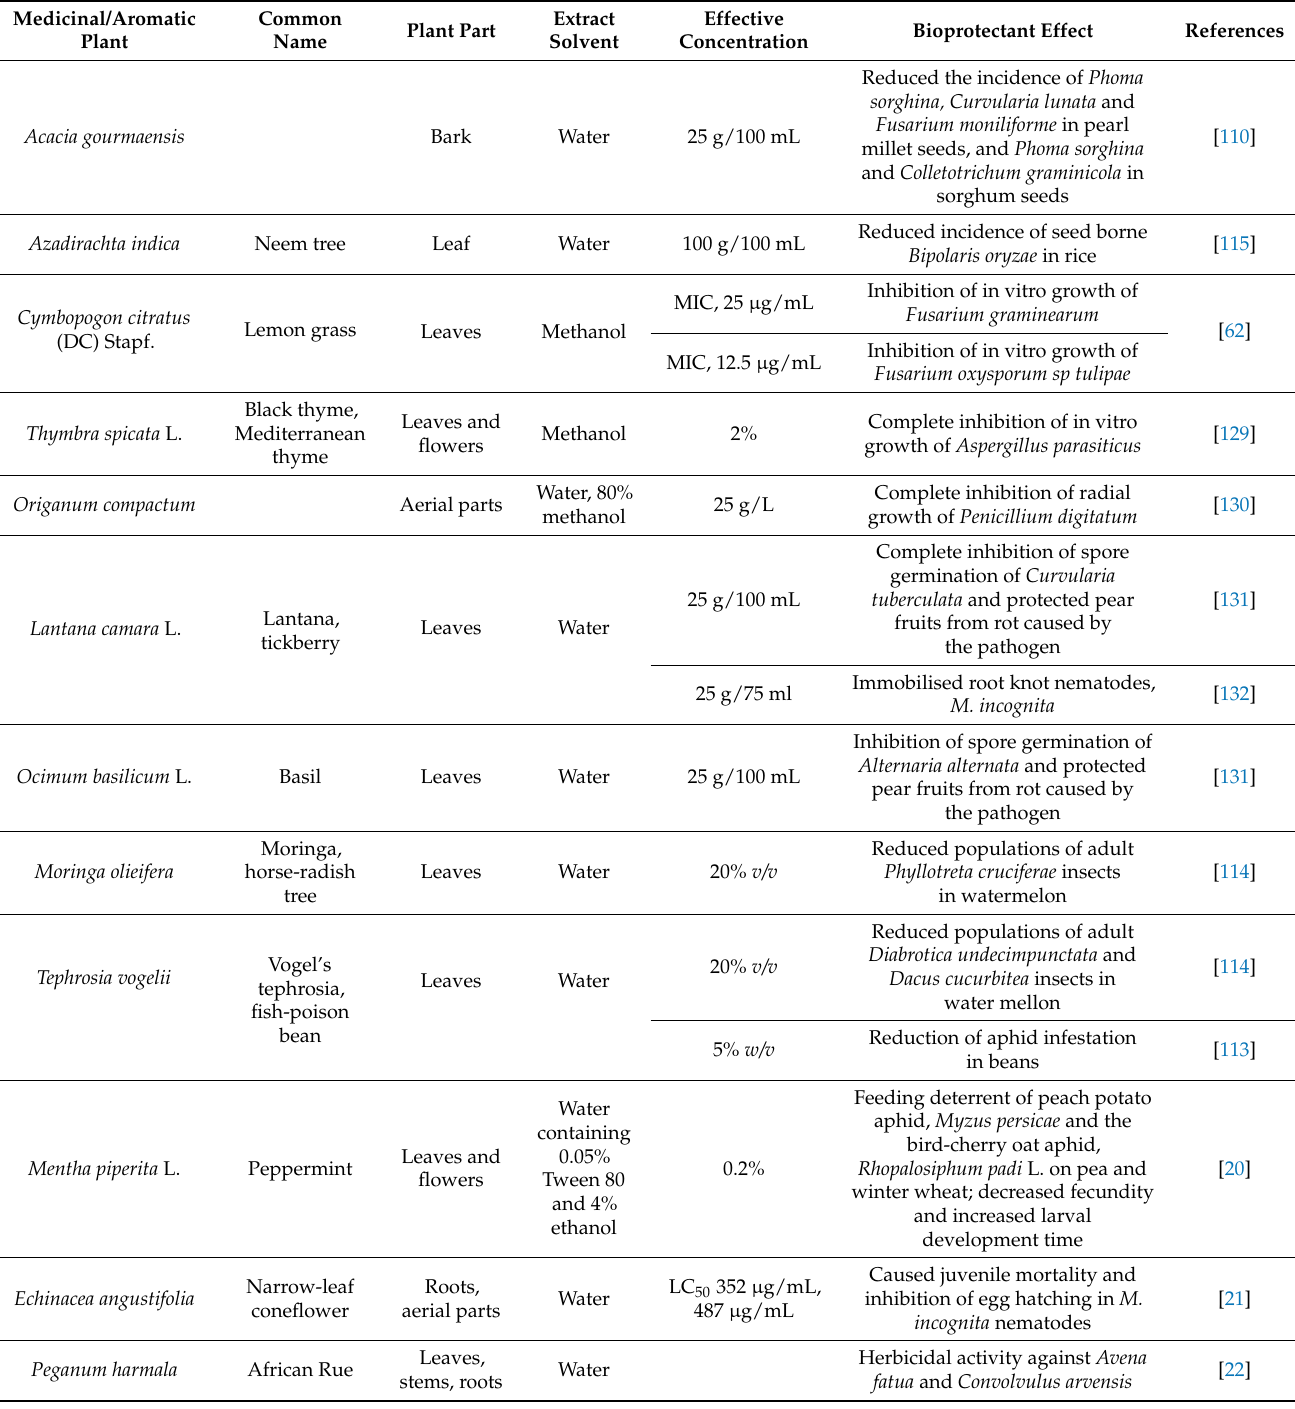
Table 5. Selected extracts from medicinal and aromatic plants with bioprotectant